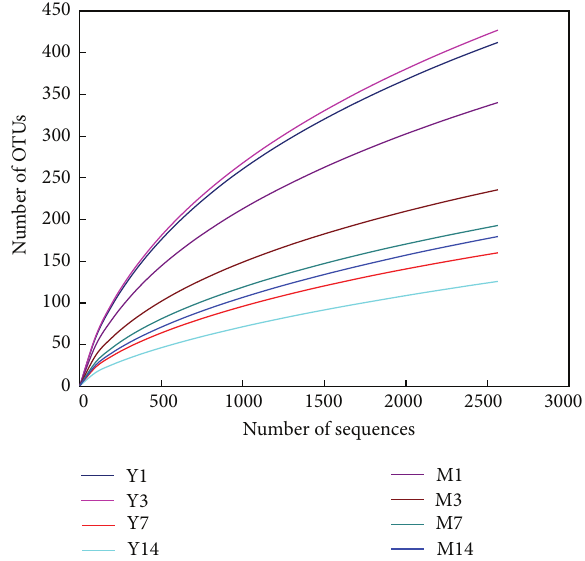
Figure 1: Rarefaction curves comparing the number of reads with the number of phylotypes (OTUs) found in the 16S rRNA gene libraries from faecal methanogens of Meishan and Yorkshire piglets. M: Meishan piglets; Y: Yorkshire piglets; 1, 3, 7, and 14 represent the ages of 1, 3, 7, and 14